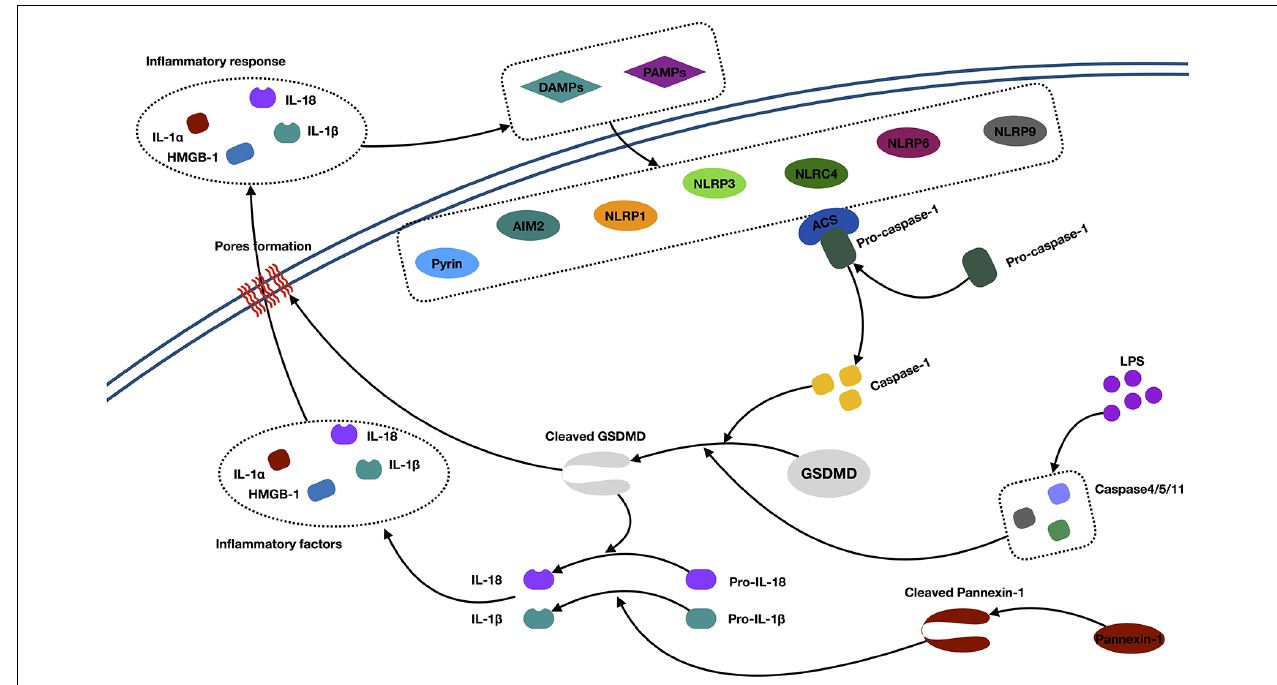
FIGURE 3 | Mechanisms of pyroptosis. Abbreviations: IL-1 α /1 β /18, interleukin 1 α /1 β /18; DAMPs, danger-associated molecular patterns; PAMPs, pathogen-associated molecular patterns; AIM2, absent in melanoma 2; NLRP, (NOD)-like receptor protein; ACS, andacyl-CoA synthetase; GSDMD, Gasdermin D; HMGB1, high-mobility group box 1; LPS,